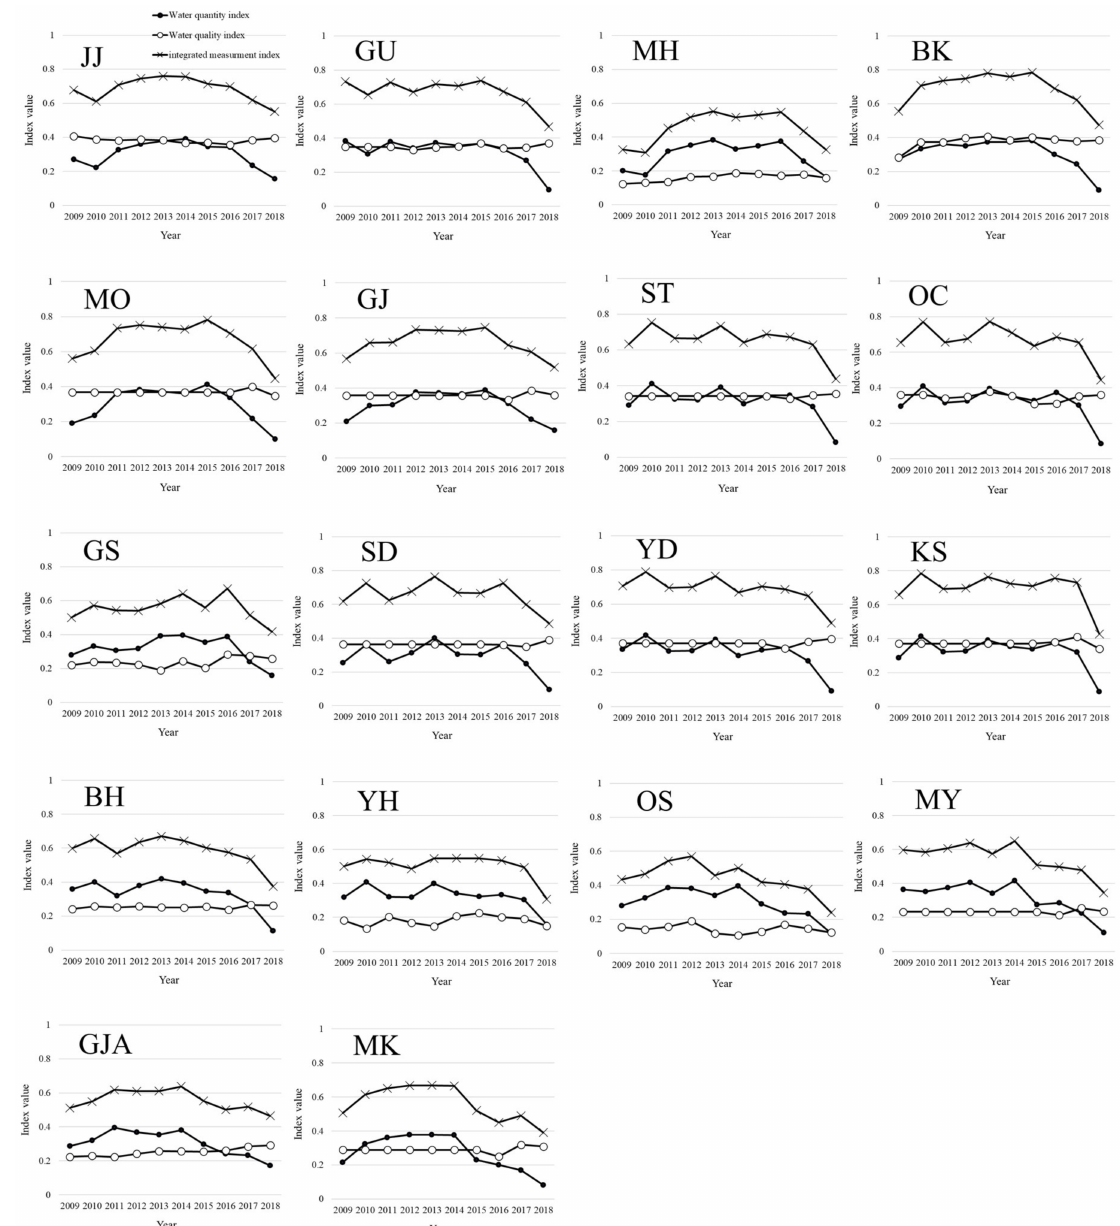
Figure 8. Variation of the annual index during the study